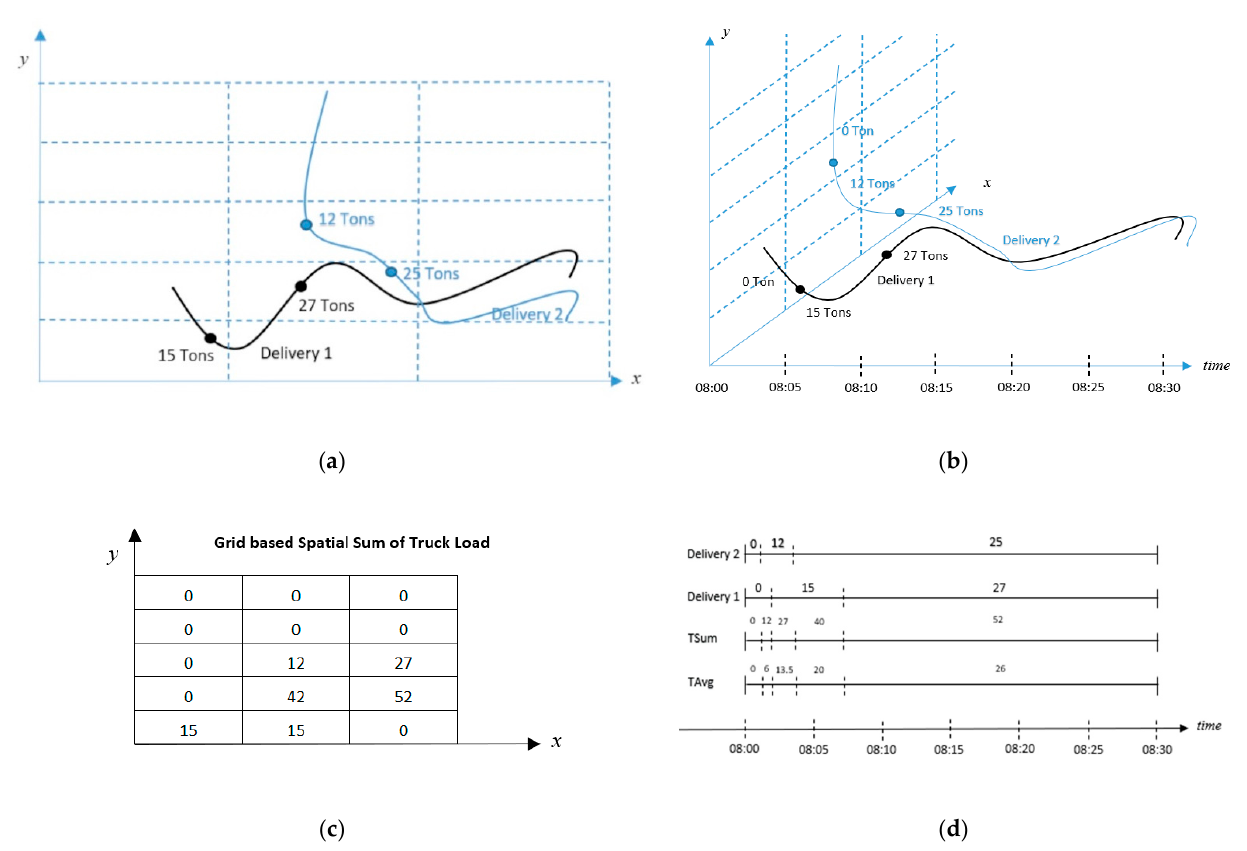
Figure 3. Example of the lifted function of trajectory mobility types ( a ) trajectory in x and y-axis, ( b ) trajectory in x,y, and time axis, ( c ) Grid-based Spatial Sum of Truckload, ( d ) TSum and TAvg lifting functions. Table 2. The function and aggregation operators of mobility types (adapted from